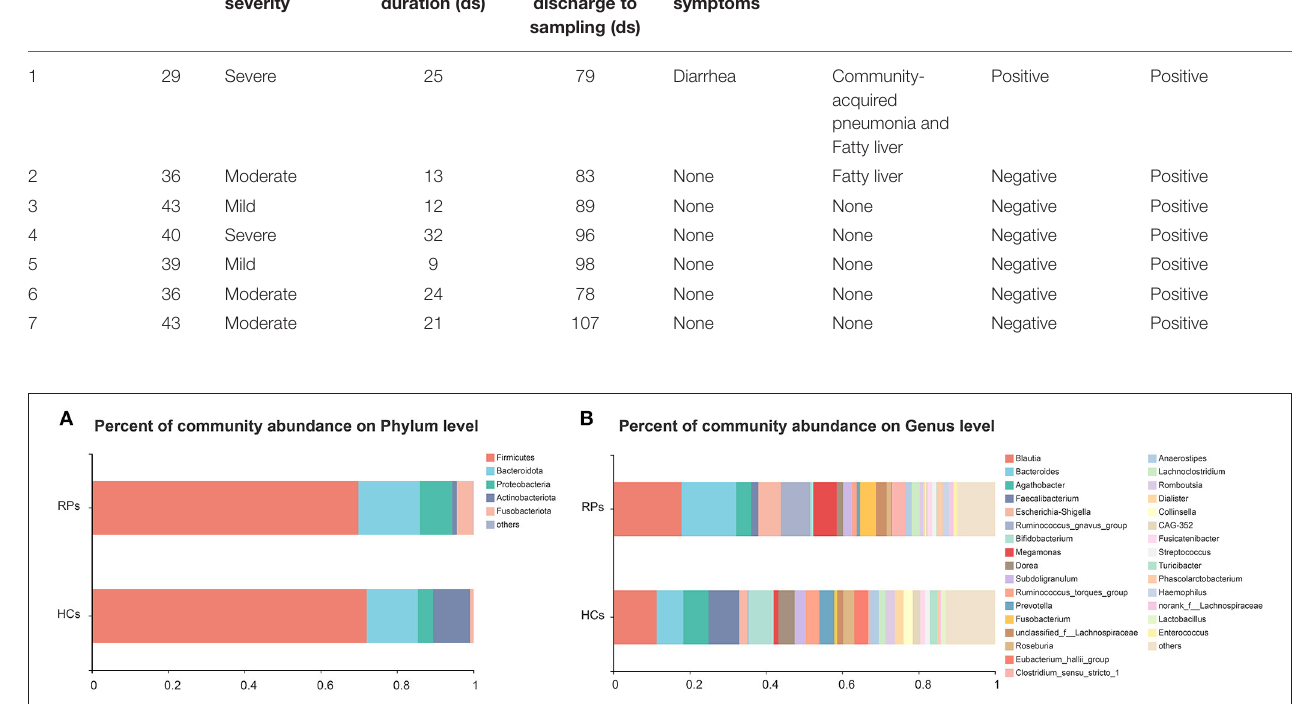
TABLE 1 | Clinical characteristics of recruited COVID-19 patients. Patient no. Age (yrs) Disease severity